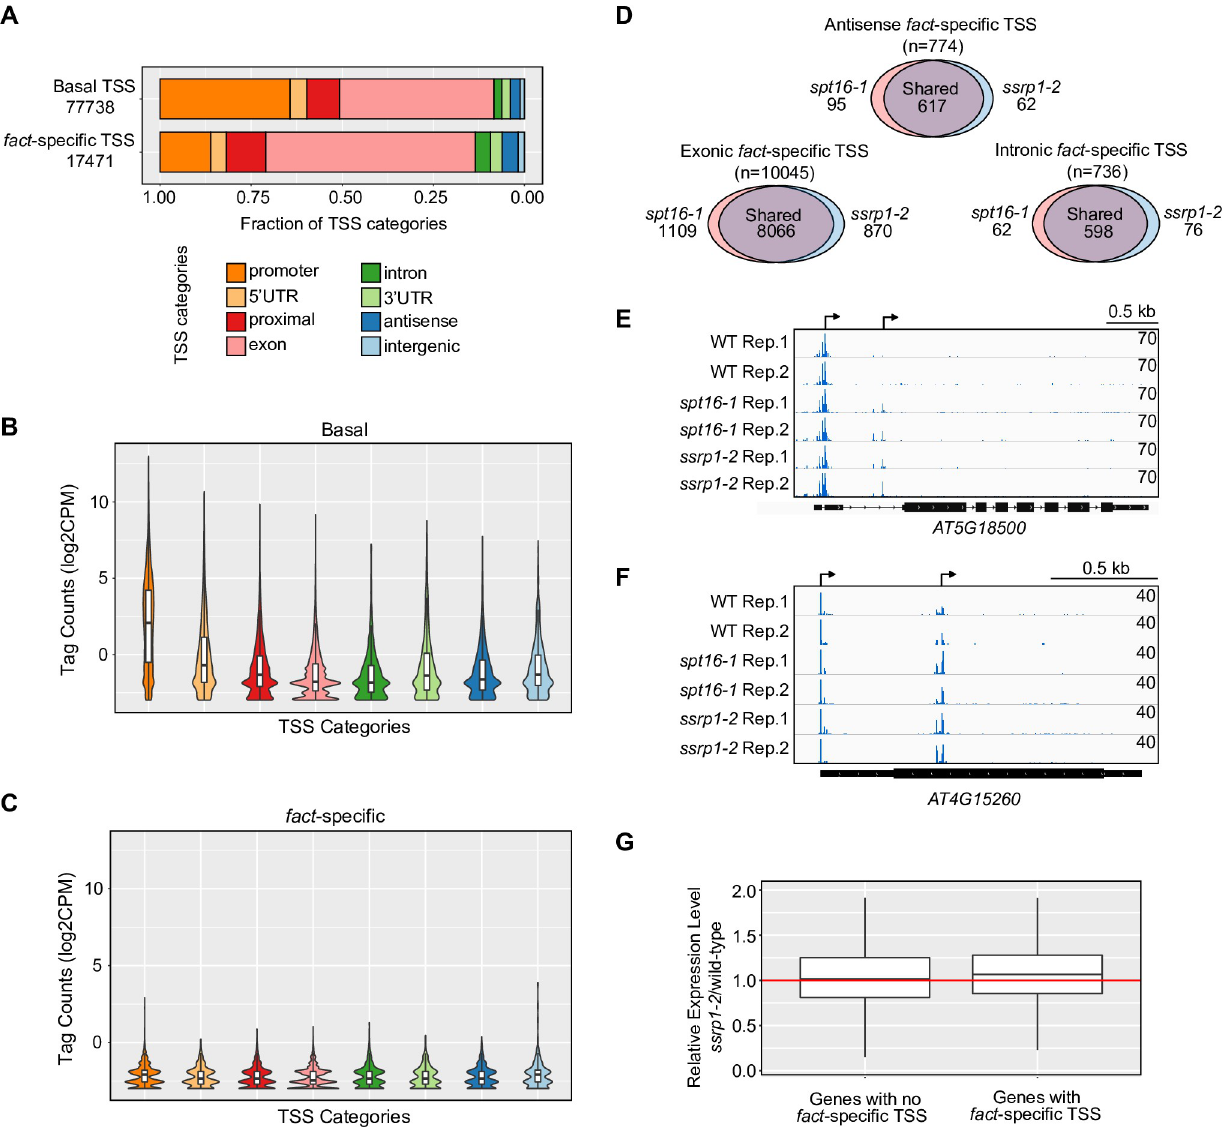
Fig 5. FACT represses intragenic TSSs across the Arabidopsis genome. (A) Genomic annotations of the basal set (upper, n = 77738) and the fact -specific set of TSSs (lower, n = 17471). (B, C) Distribution of log2-transformed expression values within each annotation category of the basal set (B) and the fact - specific set of TSS (C). (D) Venn diagrams visualizing the overlap of exonic, intronic and antisense fact -specific TSSs in spt16-1 and ssrp1-2 . (E) Genome browser screenshot of TSS-seq data showing an intronic fact -specific intragenic TSS observed in the AT5G18500 gene. AT5G18500 gene architecture is given below, the fact -specific TSSs and the promoter TSSs are indicated by black arrows (top) (F) Genome browser screenshot of TSS-seq data showing a fact -specific TSS for the AT4G15260 gene. AT4G15260 gene architecture is given below, the intragenic TSSs with increased TSS-seq signal in fact mutants and the promoter TSSs are indicated by black arrows (top) (G) Quantification of gene promoter expression ( ssrp1-2 /wild-type) between genes with and without fact -specific TSSs. Analyses are based on TSS-seq